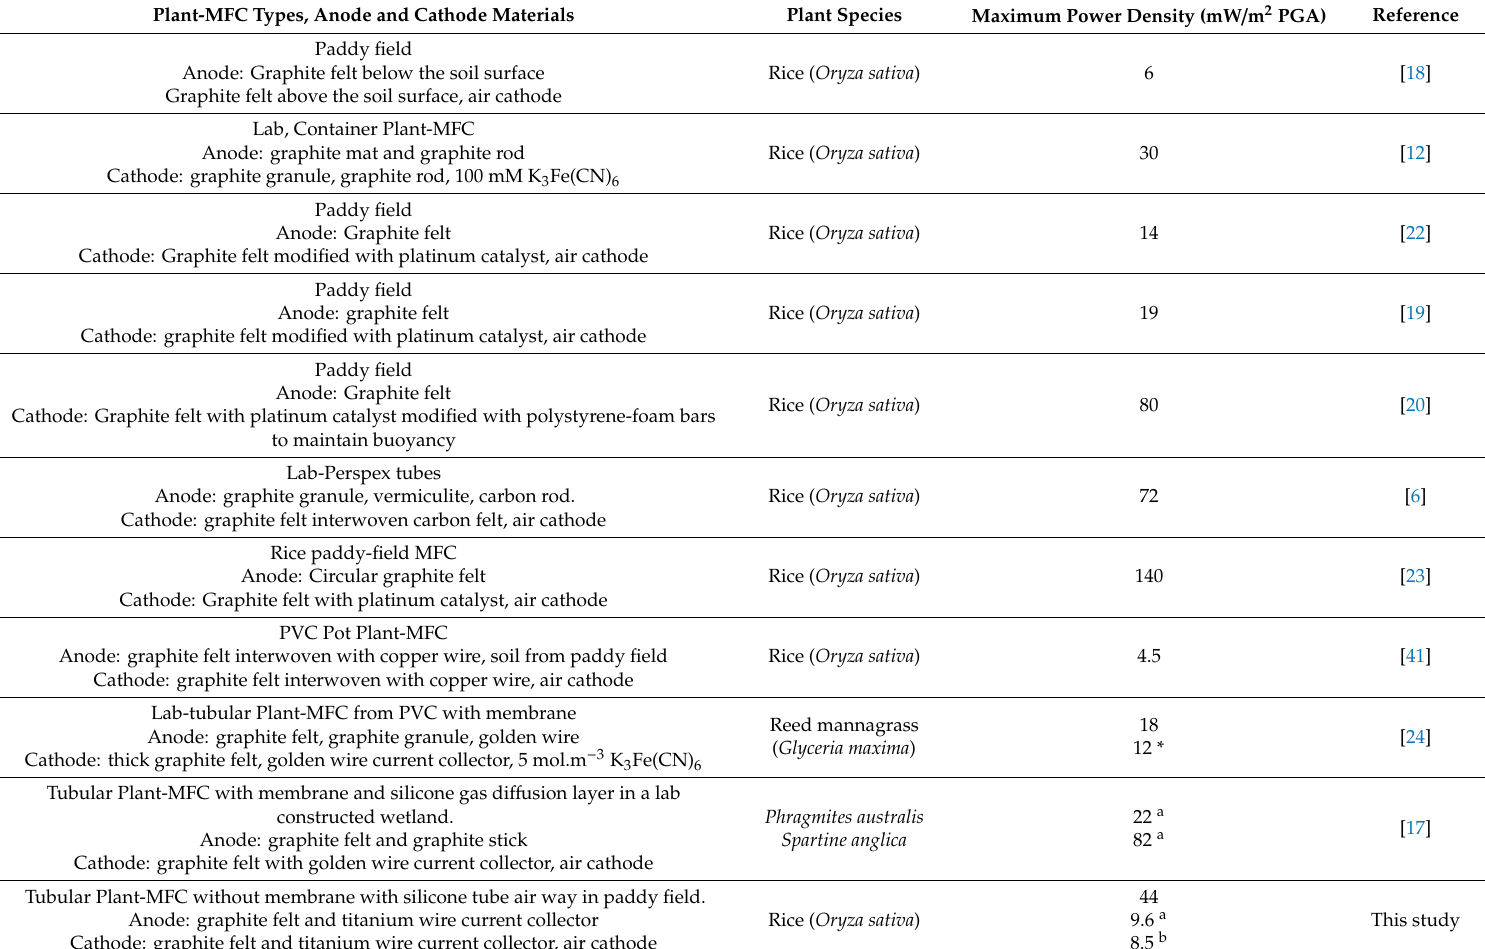
Table 3. Performances from selected Plant-MFC systems using rice of tubular